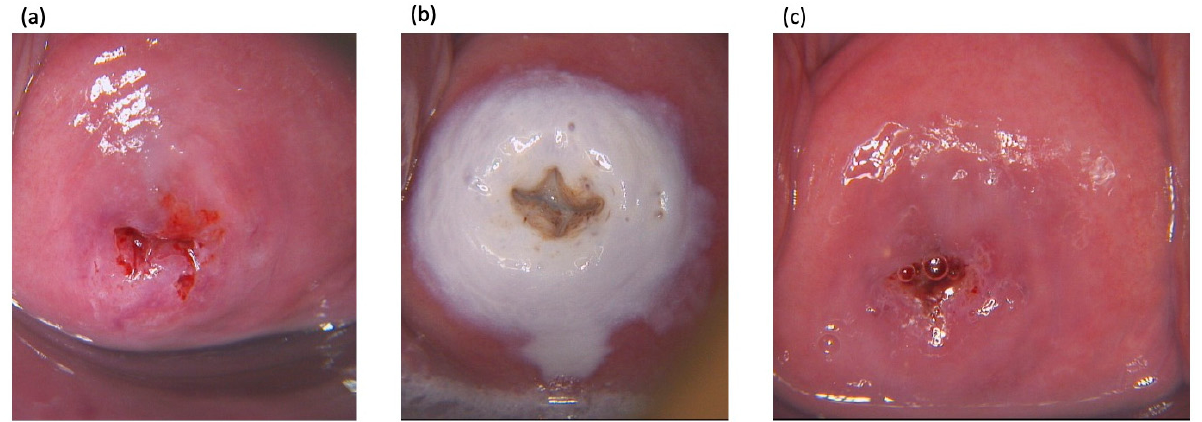
Figure 2. Colposcopic pictures of the cervix taken ( a ) before, ( b ) 10 min and ( c ) 3 months after local treatment with 85% trichloroacetic acid.